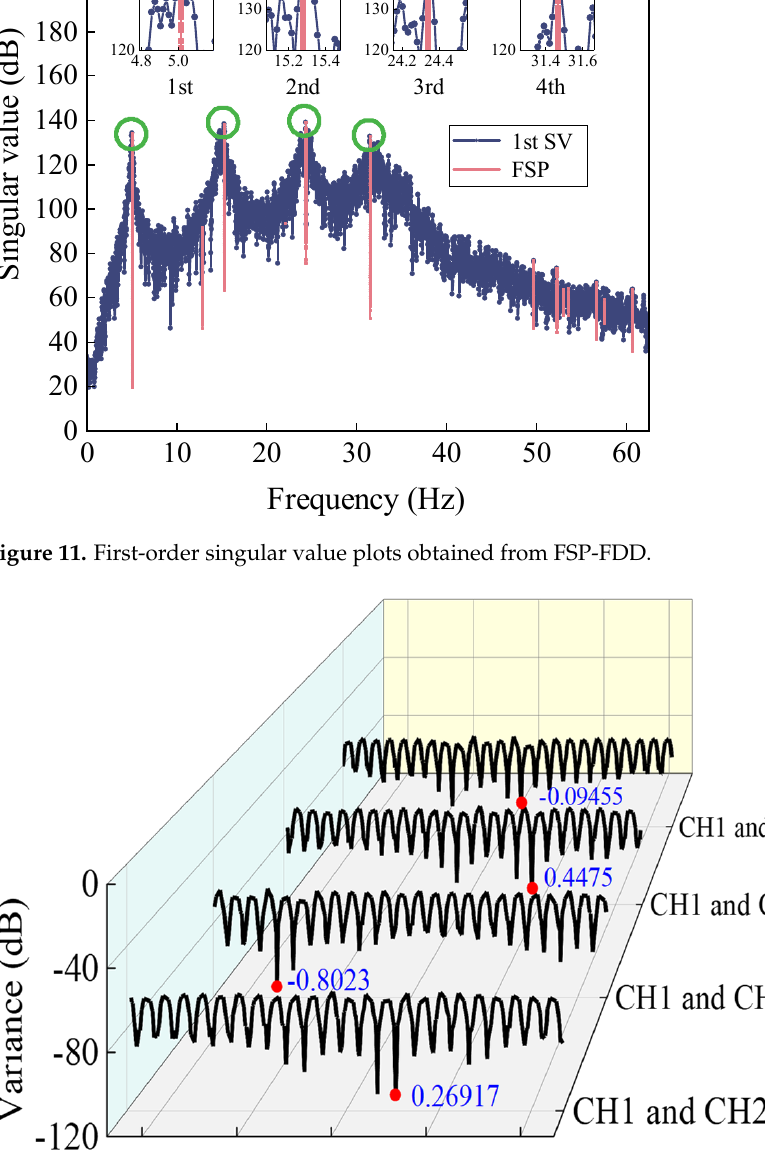
Figure 13. MAC after time lag correction. 4. Verification with Monitoring Data 4.1. Description of NSSO and Its Monitoring System To further investigate the performance of the presented approach, the field-measured data of the National Speed Skating Oval (NSSO) is adopted. The NSSO (Figure 14), located in the Beijing Olympic Park, China, was built for hosting the speed skating events during the 2022 Beijing Winter Olympics, with a span of 220 m × 153 m. It comprises four main parts: the saddle-shaped cable net, the mega ring truss, the concrete stand columns, and the stay cables. As shown in Figure 15, the cable net consists of stable cables and load- bearing cables and has a span of 200 m × 130 m. 0.999 0.004